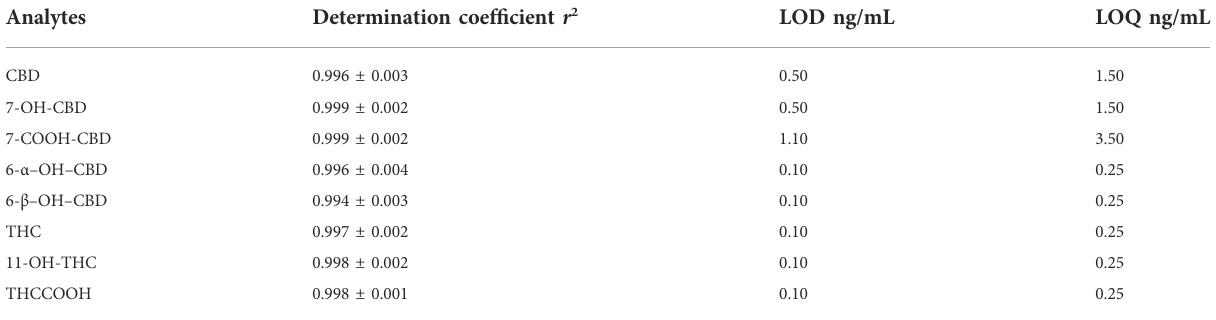
TABLE 3 Linearity, limits of detection (LOD) and limits of quanti fi cation (LOQ) for analytes under investigation in blood samples. Analytes